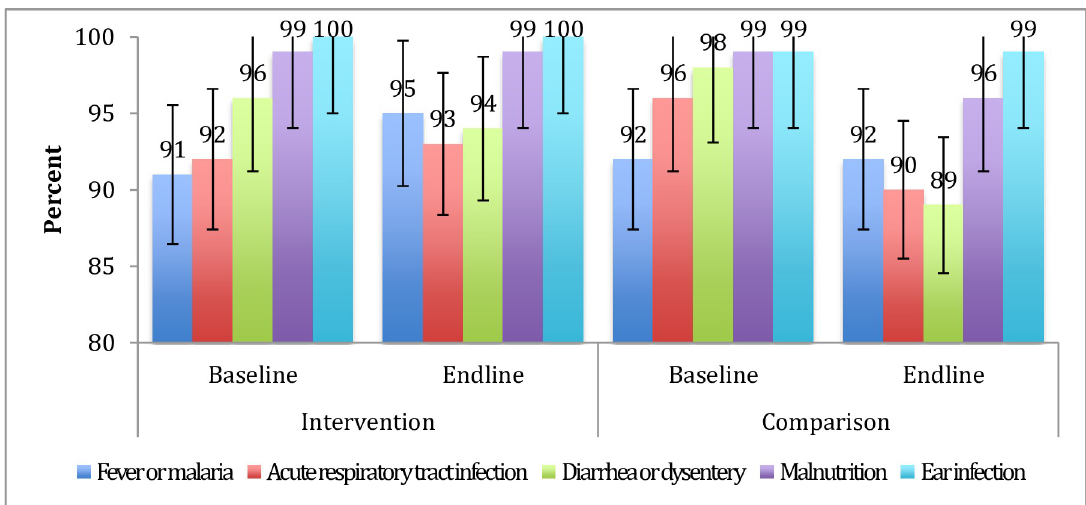
Fig 3. Specificity of the health extension workers’ disease classification among 2–59 months of age children in baseline (December 2016- February 2017) and endline surveys (December 2018-February 2019) in intervention and comparison areas.